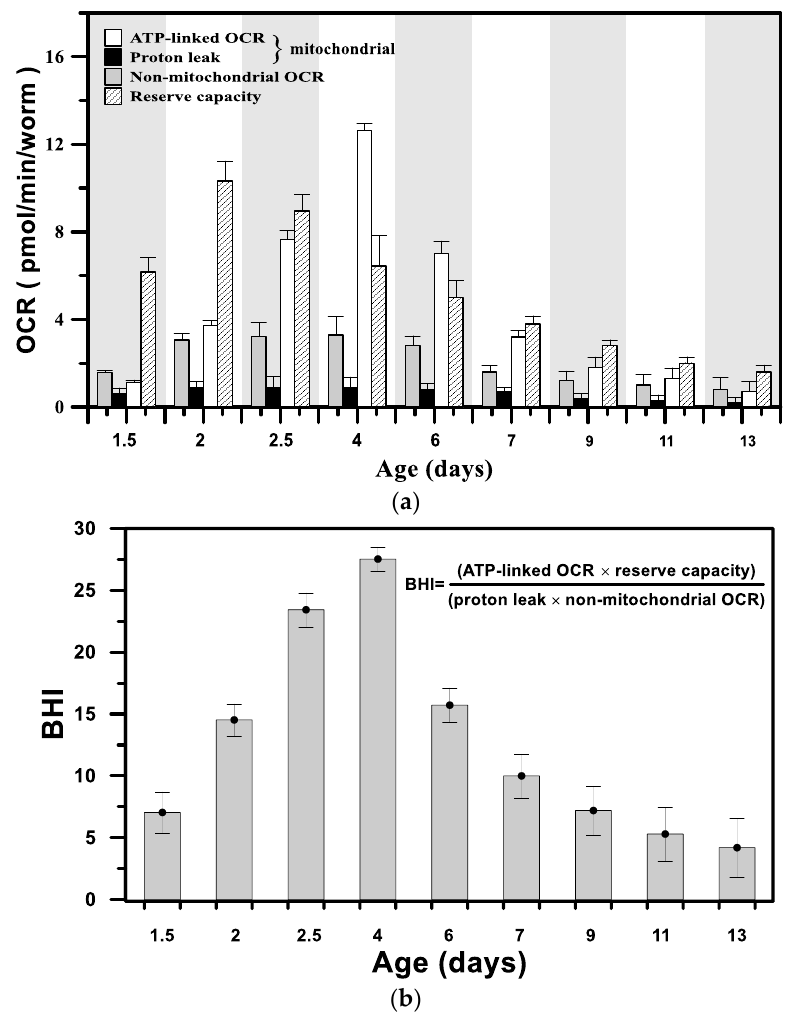
Figure 7. ( a ) The variation in ATP-linked OCR, proton leak, reserve respiratory capacity, and non-mitochondrial OCR in pmol/min/worm as a function of age from the stages of postembryonic development through adulthood to aged adult stages. ( b ) The bioenergetic health index (BHI) as a function of age, which was calculated from the fundamental parameters in (a).